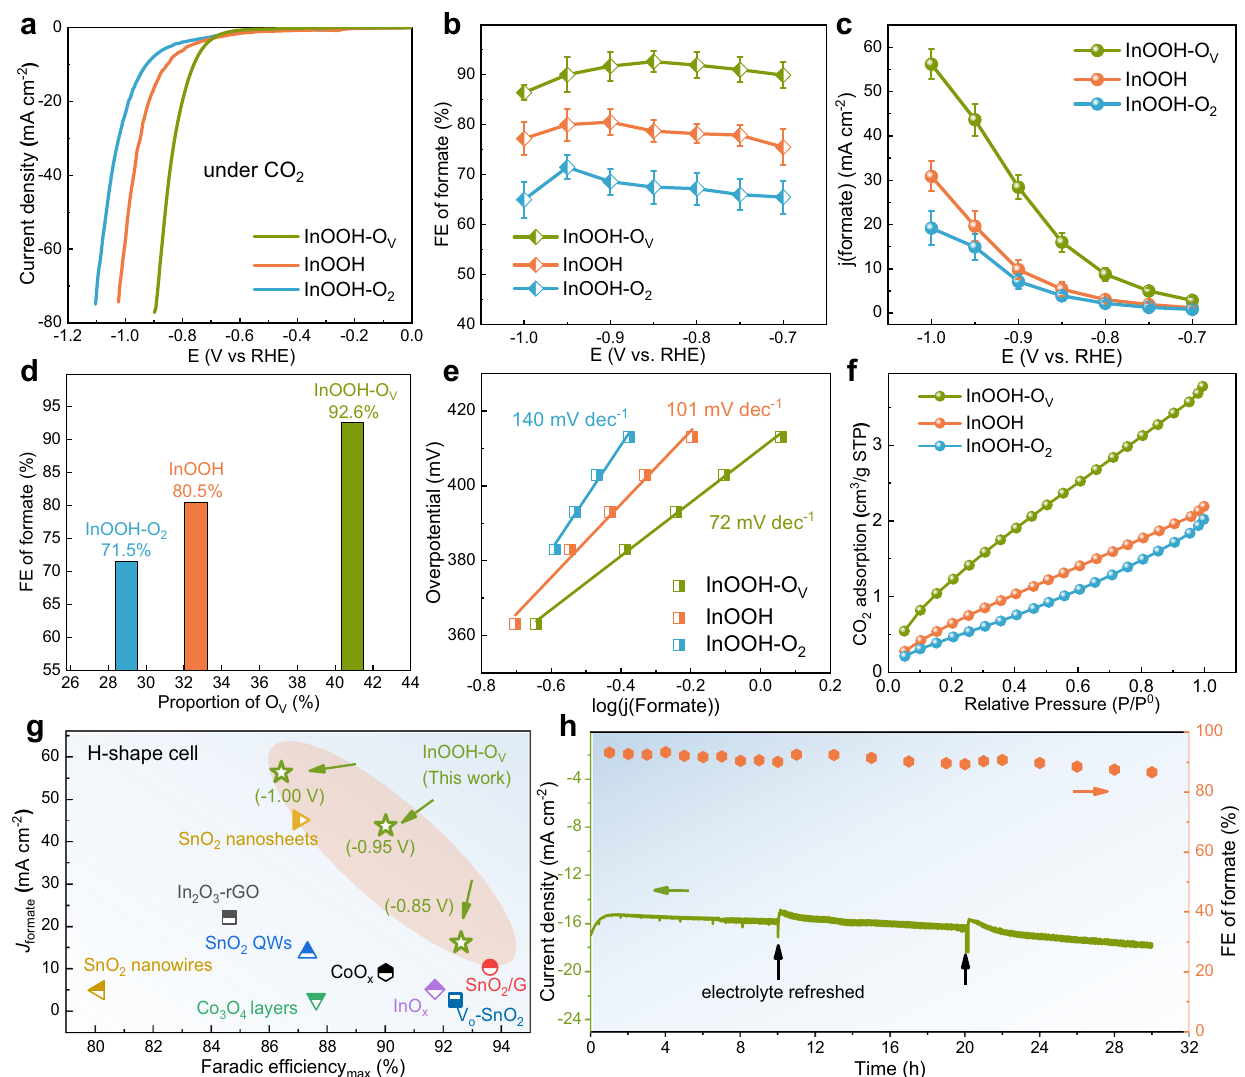
Fig. 3 | Electrochemical performances for CO 2 RR. a The LSV curves for InOOH, InOOH-O 2 ,and InOOH-O V under CO 2 atmosphere. b FEof formate and c j formate for thethreesamples. d TherelationshipbetweenmaxFEofformateandproportionof O V . e Tafel plots and f CO 2 adsorption tests for InOOH-O 2 , InOOH, and InOOH-O V .